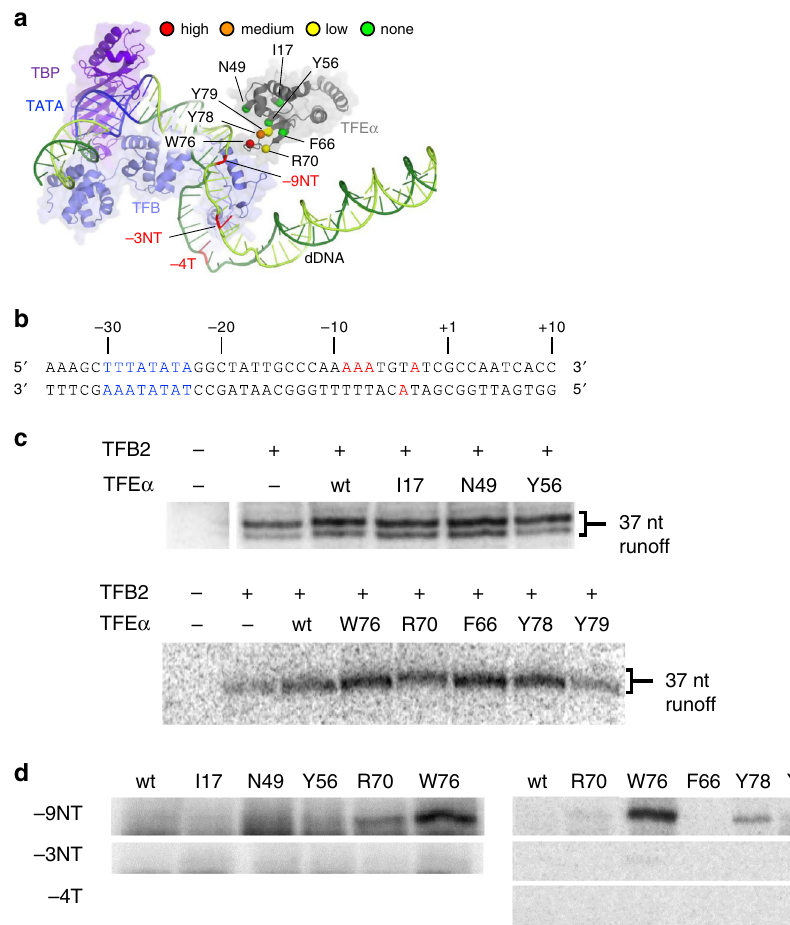
Fig. 6 TFE α and DNA interaction investigated by photo-crosslinking. a Structures of TBP, TFB, TFE α , and DNA in the OC model (Fig. 5b). Bpa substituted amino acids of TFE α ( Pfu numbering) are indicted. Colors indicate cross-linking ef fi ciency to DNA position at − 9NT. Positions at − 9NT, − 3NT, and − 4T are indicated. b DNA sequence of the gdh promoter used for photo-crosslinking. TATA box and radiolabelled positions are highlighted by blue and red, respectively. c Effects of Bpa substitution on transcription. Transcription of the gdh promoter was done in the absence (--) or presence of TFB2 and wild type and Bpa-substituted TFE α variants. Two sets of experiments are shown. In the upper set, run-off transcription gave rise to a primary transcript and a slightly shorter transcript, likely due to heterogeneity in the downstream end of the gdh promoter PCR product used. Full scan of the fi gures is in Supplementary Fig. 7. Each TFE α variant was tested at least two times, with representative results shown. d Crosslinking of TFE α Bpa variants to the gdh promoter. Preinitiation complexes were formed using gdh promoter variants radiolabelled on the NT strand ( − 9, − 8, − 7 or − 3) or the T strand ( − 4), and cross-linking triggered by UV light. Cross-linked DNA was processed by nuclease and TFE α variants that retained radiolabel (indicating proximity between Bpa and radiolabel) were identi fi ed by SDS-PAGE. The region of the gels spanning ~25 to 30 kDA is shown. Full scan of the fi gures is in Supplementary Fig. 8. Each TFE α variant was tested with each radiolabeled gdh promoter variant at least three times, with representative results